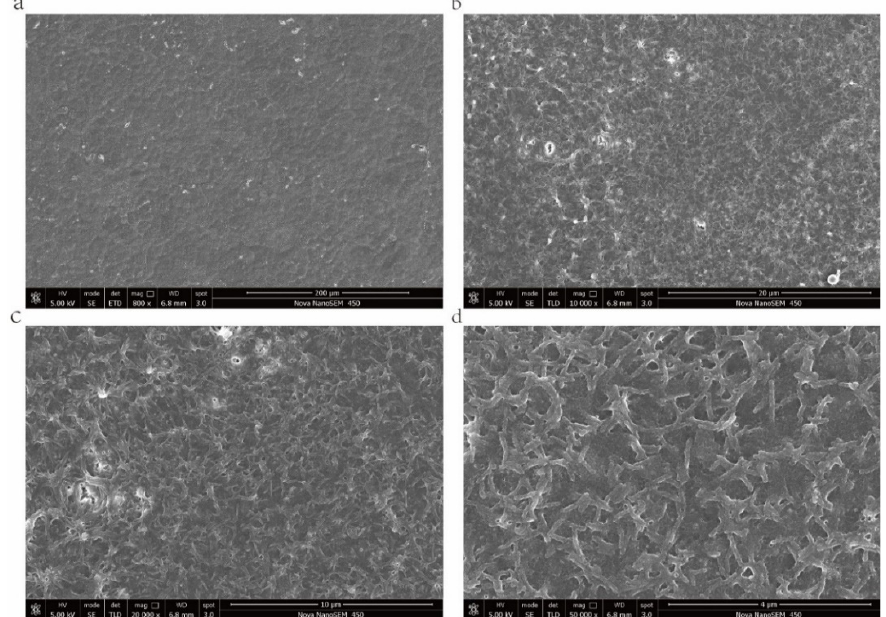
Figure 4. Morphology of monolayer Caco-2 cells under scanning electron microscope. ( a ) Caco-2 cell monolayer, Bar = 200 µm; ( b ) Caco-2 cell monolayer, Bar = 20 µm; ( c ) Caco-2 cell monolayer, Bar = 10 µm; and ( d ) microvilli structure, Bar = 4 µm.